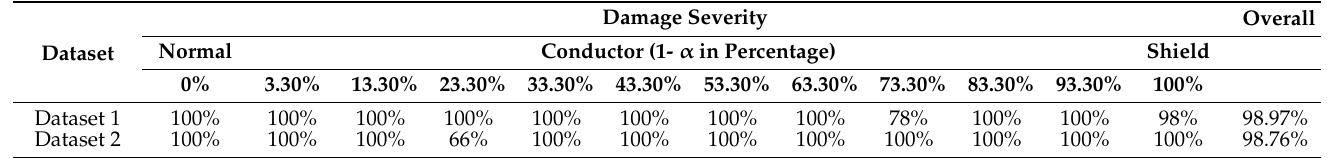
Table 3. Offline fault detection accuracies of soft faults in the